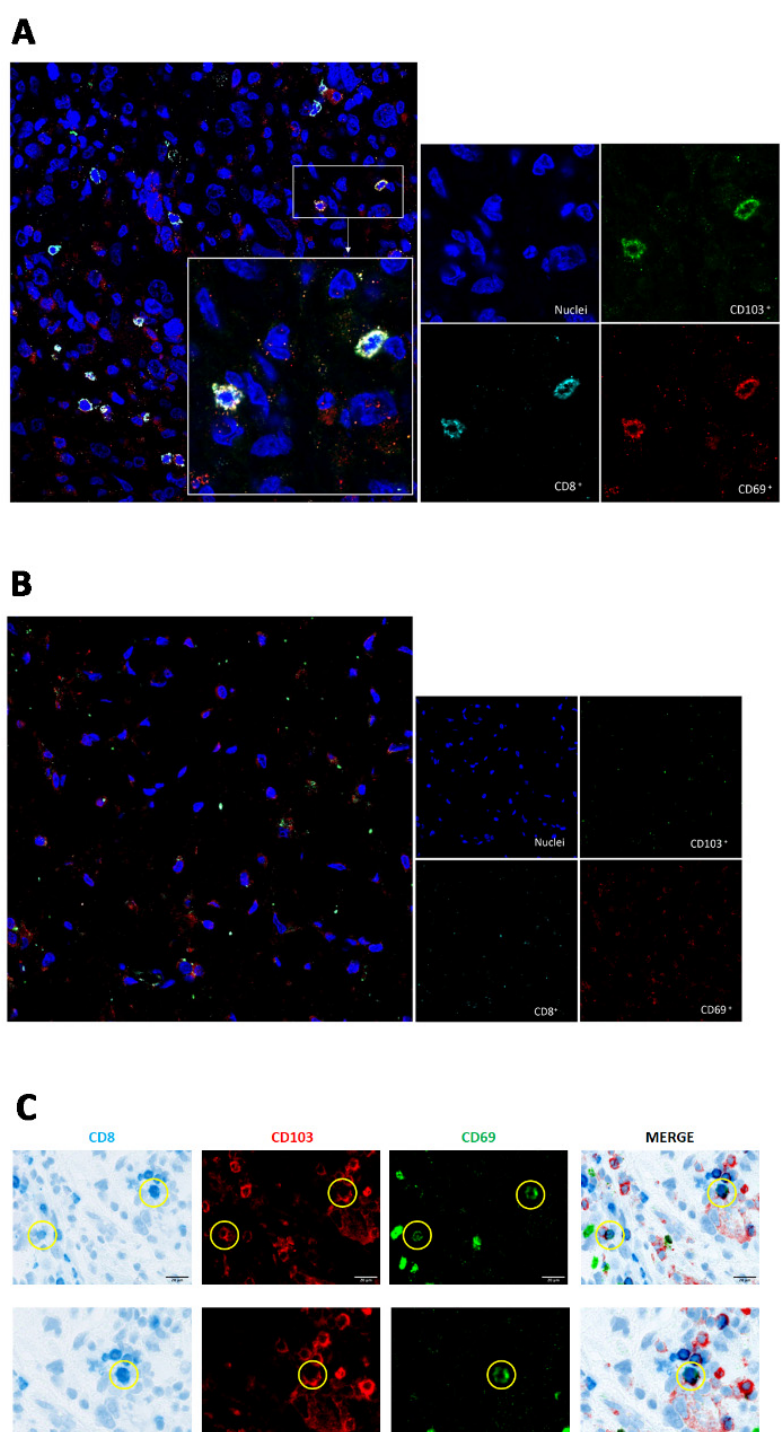
Figure 3. CD8 + TRM cells infiltrate tumor tissue in GBM patients. ( A ) confocal microscopy analysis from the CLADIBIOR laboratory shows the localization of the surface markers (CD103 green signal and CD69 red signal) of CD8 + TRM cells in a representative GBM sample, and ( B ) their absence in meningioma. Original magnifications, × 400, and × 630. ( C ) Two representative microphotographs from the Tumor Immunology Unit’s laboratory, of multiplexed immunostaining for CD8 (blue signal), CD103 (red signal), and CD69 (green signal) in human glioblastoma FFPE sample. Original magnifications, ×400 and ×630.